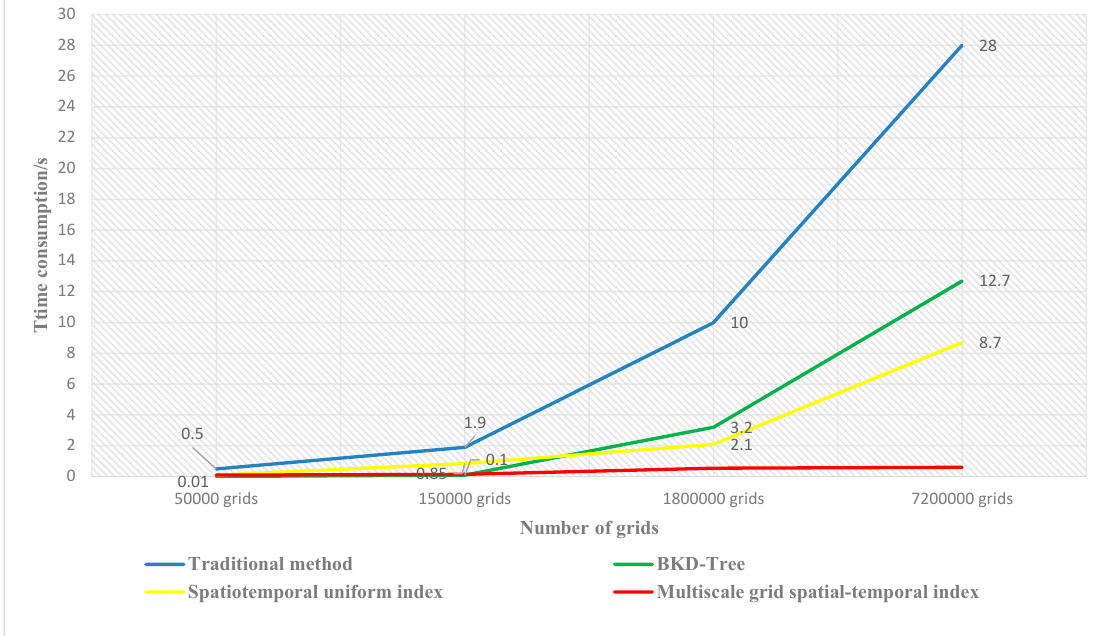
Figure 11. Comparison of flight conflict detection efficiency among different methods.